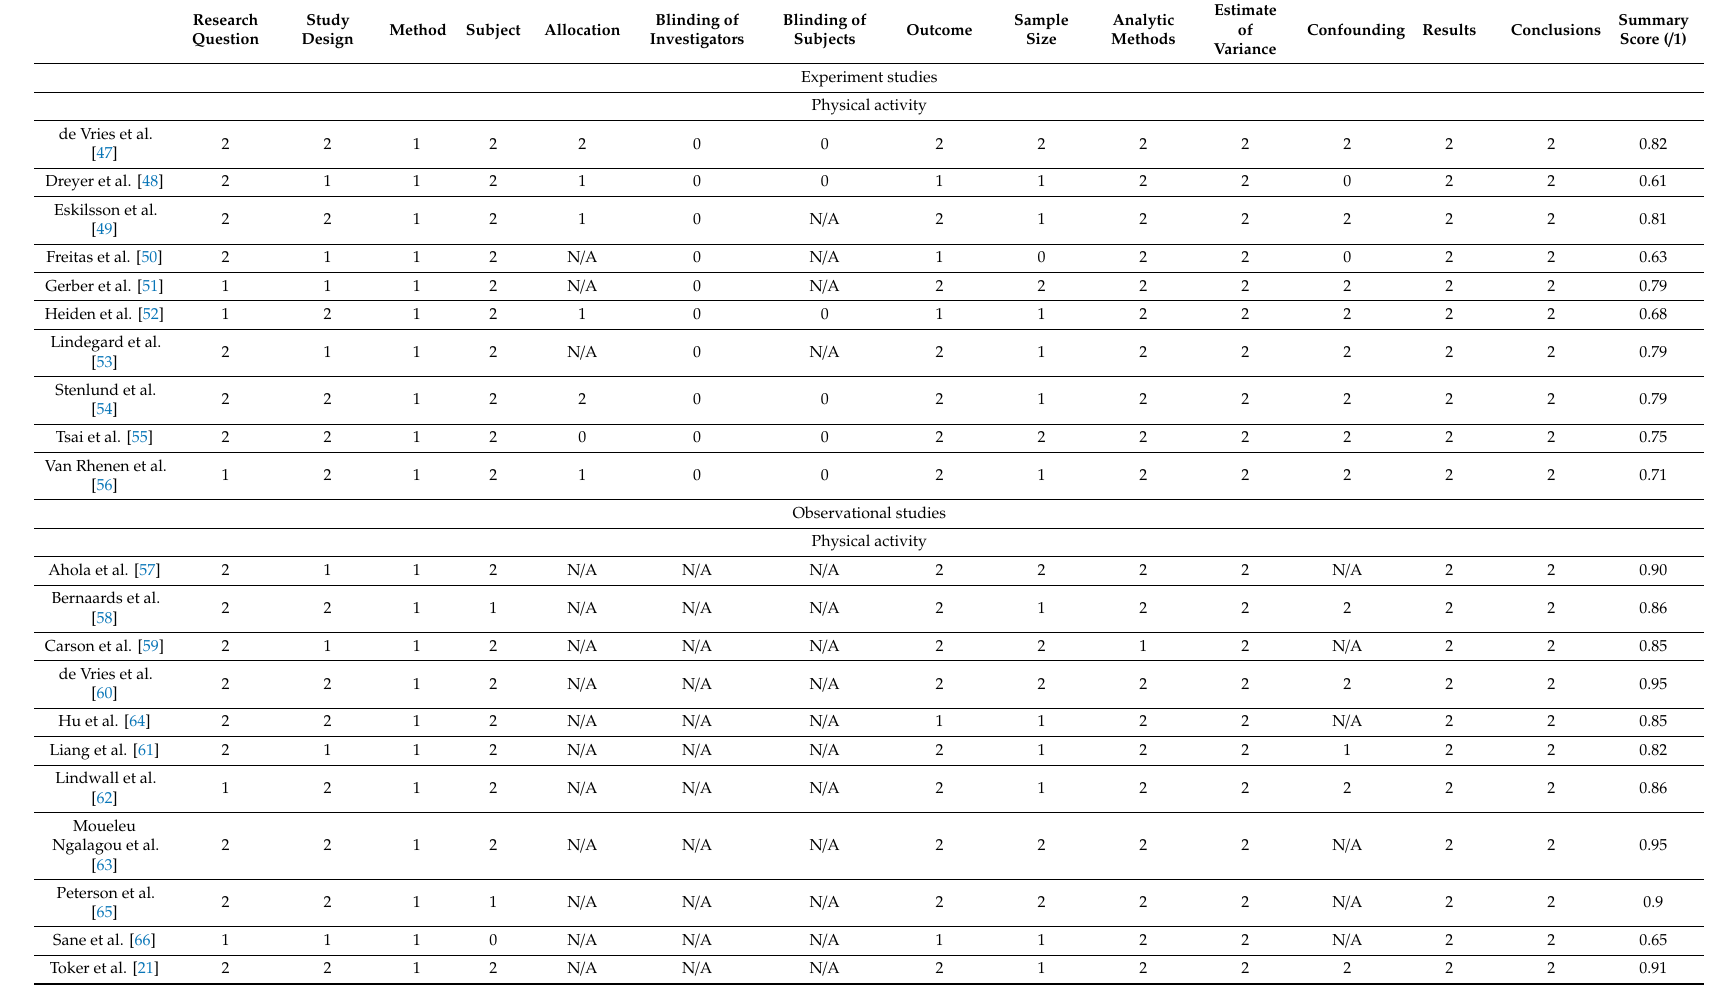
Table 3. Quality assessment of the included